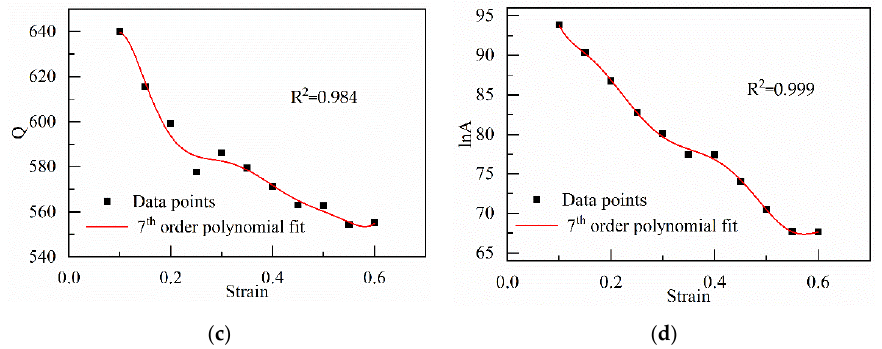
Figure 8. Variation of ( a ) ln α ; ( b ) n ; ( c ) ln A; ( d ) Q with true strain represented by a 7th order of the polynomial.